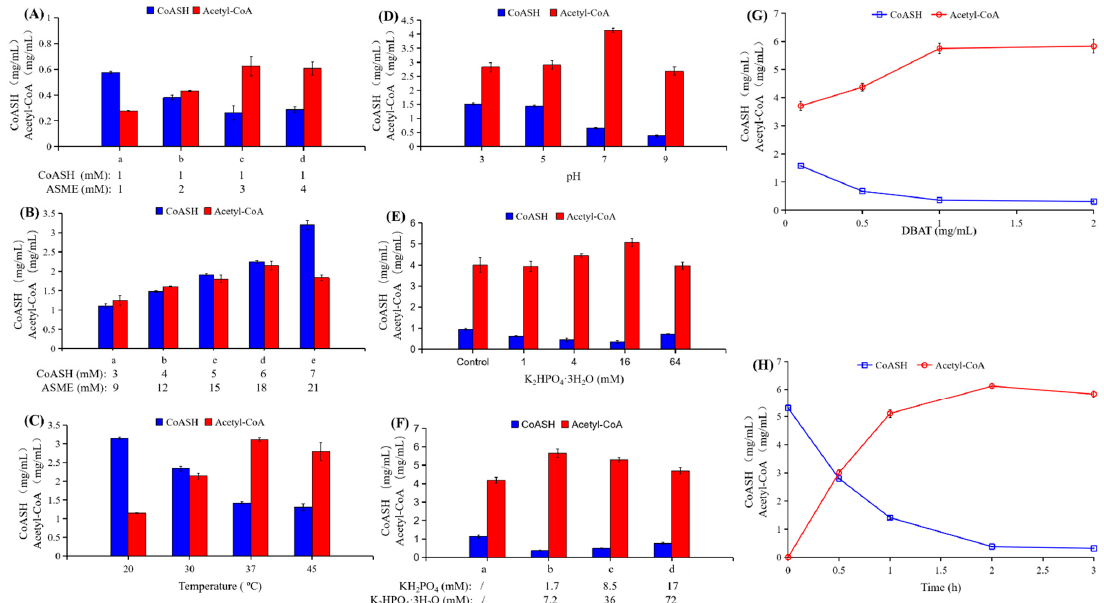
Figure 3. Optimization of DBAT-mediated acetyl-CoA in vitro biosynthesis with ASME as the acetyl donor. ( A ) The influence of different molar concentrations of CoASH and ASME on the production of acetyl-CoA (DBAT = 1 mg/mL). ( B ) The influence of different molar concentration combinations of CoASH/ASME on the production of acetyl-CoA. The molar ratio of CoASH/ASME was defined as 1/3 (DBAT = 1 mg/mL). ( C ) The influence of different temperatures on the production of acetyl-CoA (CoASH/ASME = 6 mM/18 mM, DBAT = 1 mg/mL). ( D ) The influence of different pH levels on the production of acetyl-CoA (CoASH/ASME = 6 mM/18 mM, DBAT = 1 mg/mL, at 37 ◦ C). ( E ) The influence of different K 2 HPO 4 • 3H 2 O concentrations on the production of acetyl-CoA, (CoASH/ASME = 7 mM/21 mM, DBAT = 1 mg/mL, at 37 ◦ C, pH 7.0). ( F ) The influence of different concentration combinations of KH 2 PO 4 /K 2 HPO 4 • 3H 2 O on the production of acetyl-CoA, (CoASH/ASME = 7 mM/21 mM, DBAT = 1 mg/mL, at 37 ◦ C, pH 7.0). ( G ) The influence of different DBAT concentrations on the production of acetyl-CoA, (CoASH/ASME = 7 mM/21 mM, KH 2 PO 4 /K 2 HPO 4 • 3H 2 O = 1.7 mM/7.2 mM, at 37 ◦ C, pH 7.0). ( H ) The influence of different reaction times on the production of acetyl-CoA, (CoASH/ASME = 7 mM/21